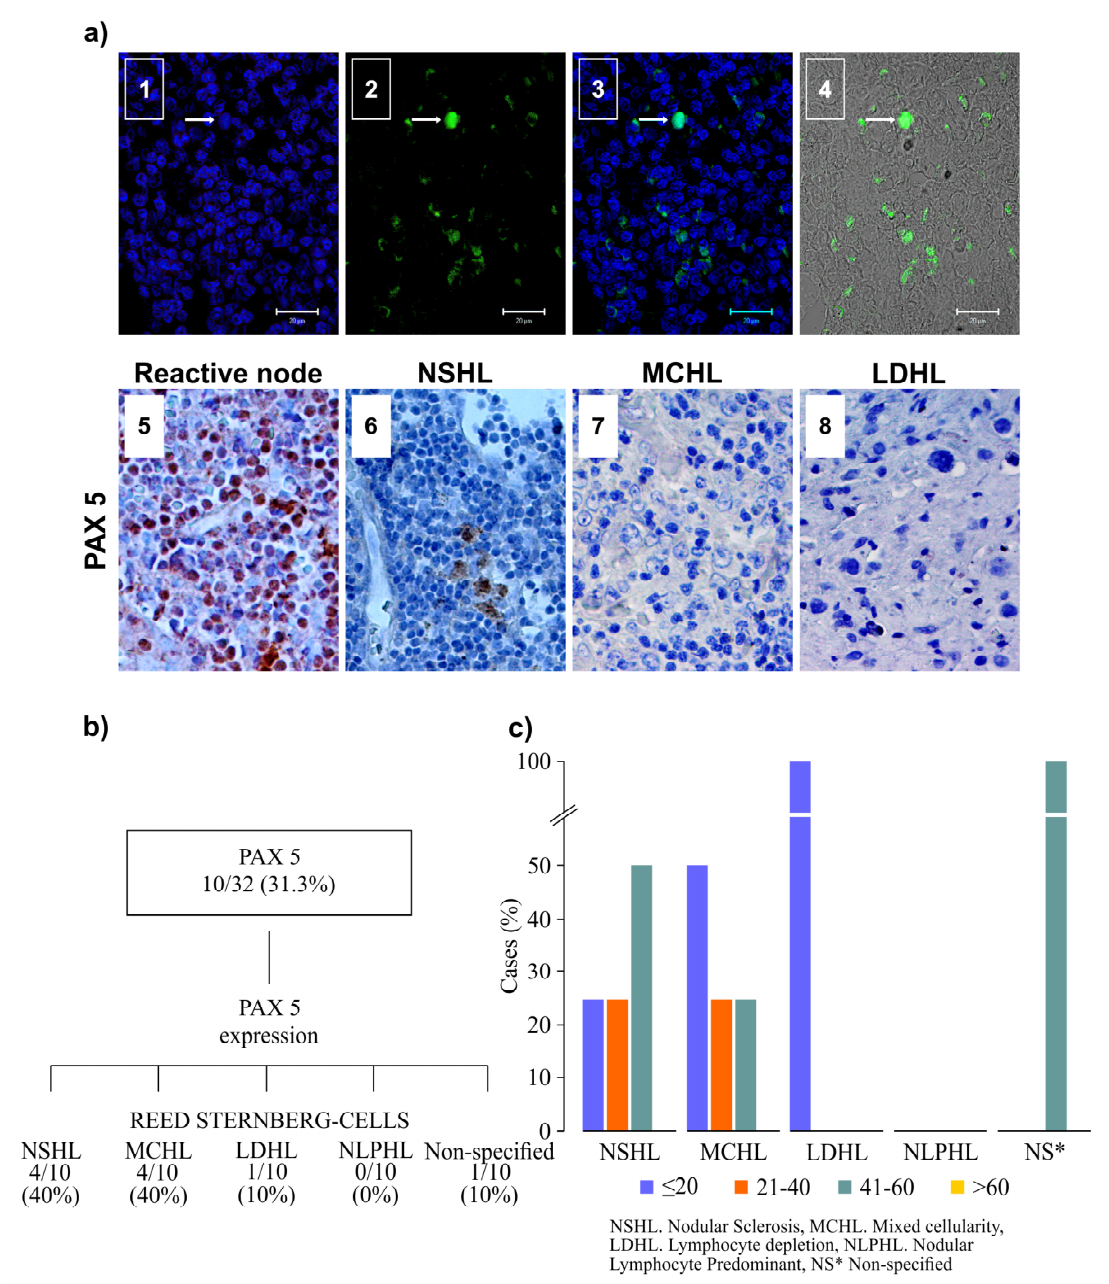
Figure 3. PAX5 expression in cHL. ( a ) Immunoreactivity for PAX5 by Multi-channel fluorescence microscopy automated image system (Applied Imaging Co.) (1–4) and by immunohistochemistry (5–8). 1. Confocal analysis showing the labeling of cHL nuclei by DRAQ7TM (blue) in a case of NSHL; 2. PAX5 labeling with fluorescein, arrow (green); 3. Merge of nuclei and immunoreactivity for PAX5; 4. Optical transmission showing the analyzed area of the tissue and labeling of PAX5; 5. Negative control for PAX5; 6. Immunoreactivity for PAX5 in NSHL; 7. Negative immunoreactivity for PAX5 in MCHL; 8. Negative immunoreactivity for PAX5 in LDHL (original magnification × 400: bars 20 µ m). ( b ) Graph showing the number of cases identified with the di ff erent types of cHL for PAX5-positive immunoreactivity. ( c ) The graph shows the percentage of cases that expressed PAX5 in the di ff erent types of cHL and the range of Reed–Sternberg cells (RSC) positive for PAX5 by immunohistochemistry in para ffi n-embedded